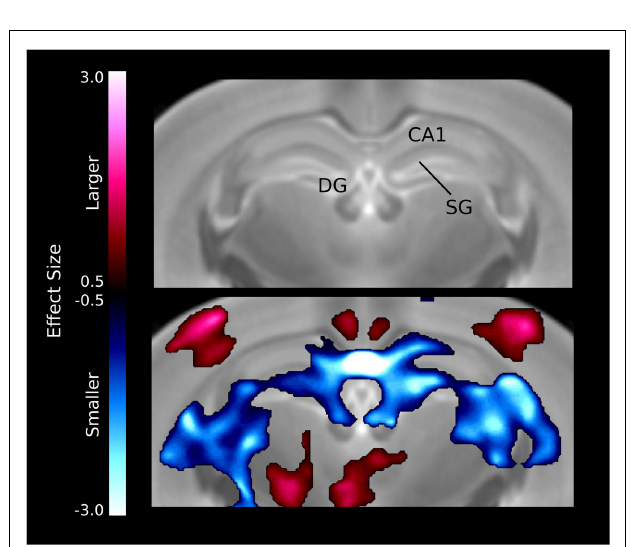
FIGURE 5 |Volume differences in the hippocampus. The differences are localized around the midline CA1 region as well as the dentate gyrus (DG) and stratum granulosum (SG).